Question: Summarize what this figure shows in one sentence.
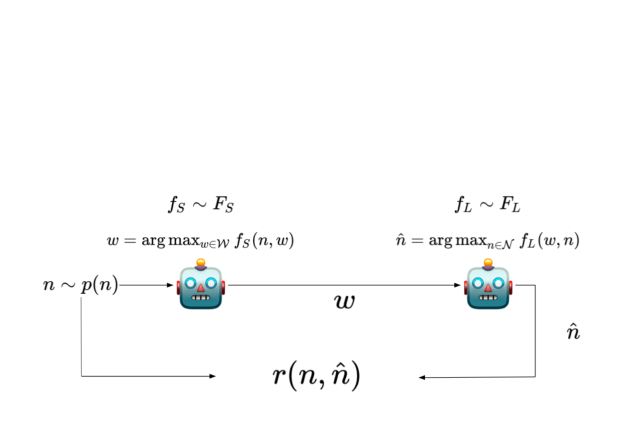
Answer: Illustration of one round of our Lewis signaling game, which will be formally introduced in later sections. The sender is given a number n and samples a model fS from FS using dropout and conveys the word w giving highest re- ward according to fS. The listener proceeds in similar fash- ion, given w it samples a model fL from FL and guesses the number ˆn that yields most reward according to fL. A shared reward is given to both agent based on how close ˆn is to n.